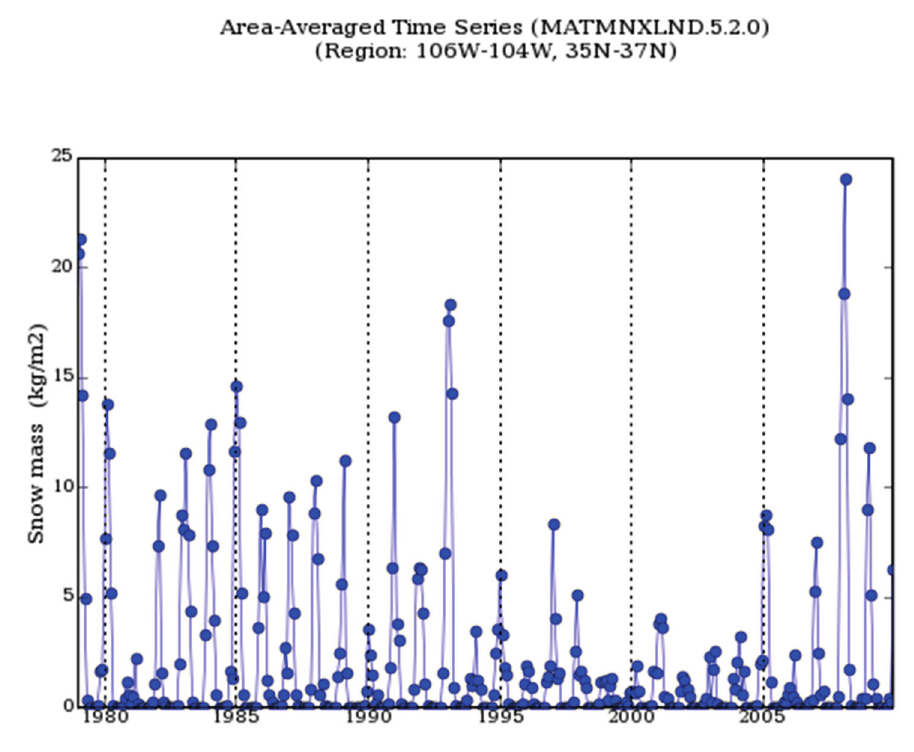
Figure 2. Monthly time-series of Modern Era Retrospective-analysis for Research and Applications (MERRA) snow mass data, plotted with Giovanni, for the central mountainous region of northern New Mexico,